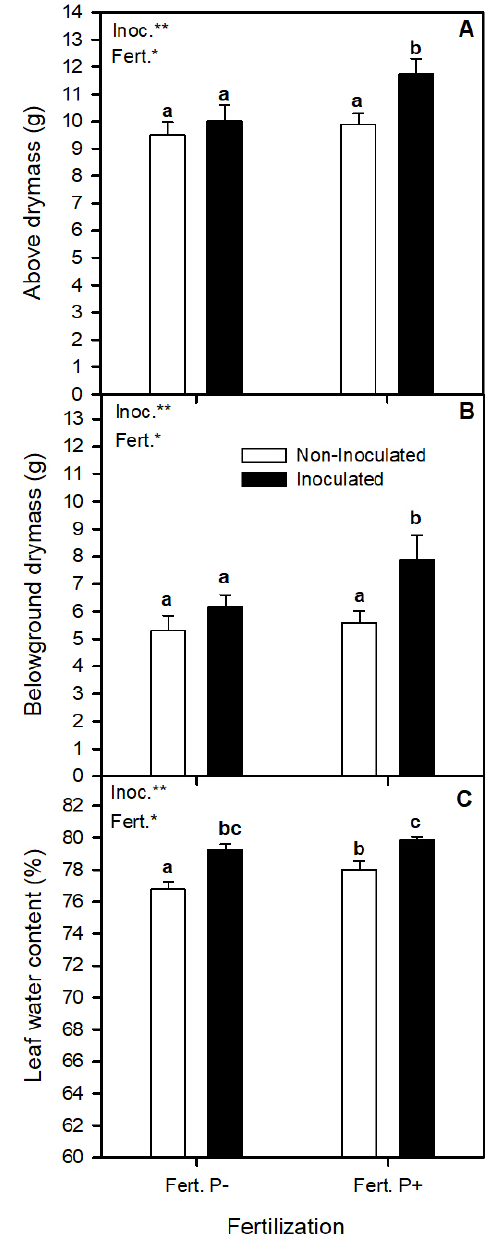
Figure 1. Aboveground dry mass ( A ), belowground dry mass ( B ), and leaf water content ( C ) in strawberry plants fertilized with BNM medium without phosphorus (Fert. P − ) or with BNM medium supplemented with an insoluble phosphorus form (Fert. P+) and subjected to two inoculation treatments after 120 days of treatment. Values represent mean ± SE of 10 replicates. Inoc., Fert., or Inoc. x Fert. in the panel corner indicate principal or synergistic significant effects. Different letters indicate means that are significantly different from each other. (LSD test, * p < 0.05, ** p <